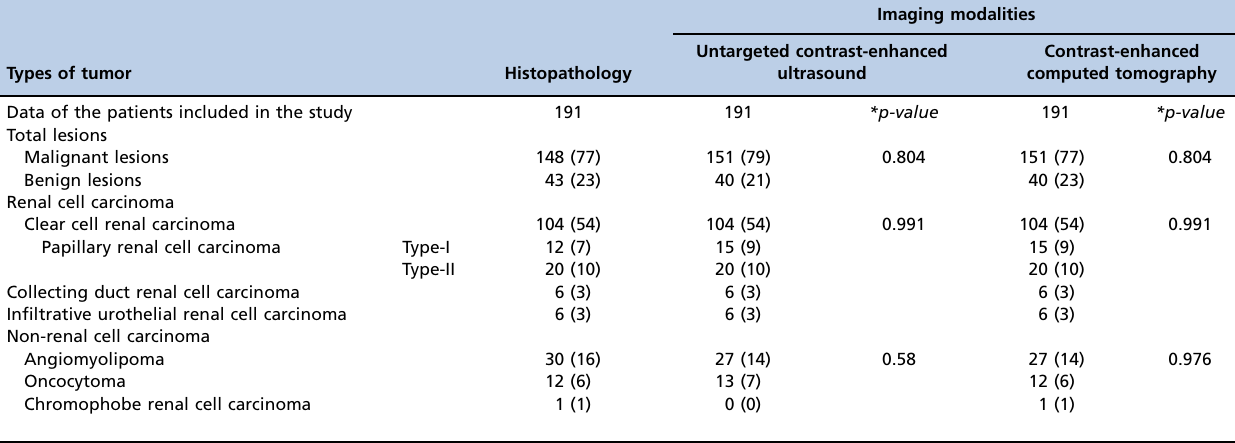
Figure 8 - Histopathological examinations. A: Clear cell renal carcinoma (lipid-rich cytoplasm with sharply visible nuclei), B: Papillary renal cell carcinoma-type I (spindle-shaped basophilic cells with scarce cytoplasm), C: Papillary renal cell carcinoma-type II (spindle- shaped organized cells covered with granular eosinophils with distinct nuclei), D: Chromophobe renal cell carcinoma (large cells with pale surroundings and perinuclear halos), E: Collecting duct renal cell carcinoma (irregular channels were lined by high-grade cuboidal to hobnail cells with eosinophilic cytoplasm). F: Infiltrative urothelial renal cell carcinoma (sessile, polypoid, fungating, ulcerated, and infiltrative lesion with the neoplastic cells separated by a desmoplastic stroma). G: Oncocytoma (nested architecture with a central scar and bland cytology). Table 3 - Tumors and their subtypes examined by the diagnostic